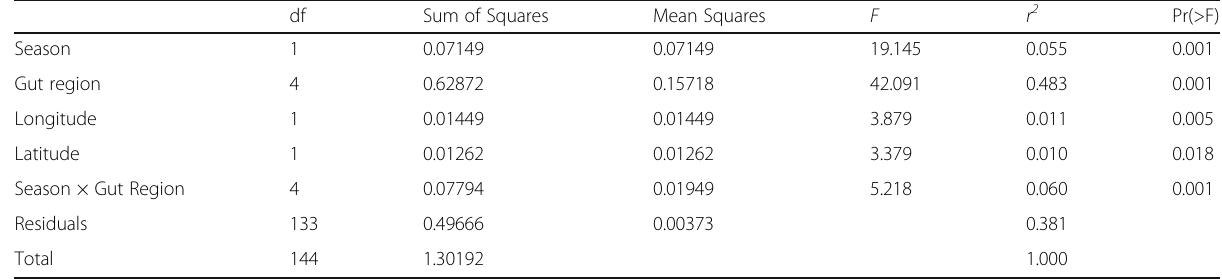
Table 1 PERMANOVA results comparing the effect of the gut region, season, and geographic coordinates on the weighted UniFrac distances among all samples df Sum of Squares Mean Squares Season Gut region Latitude